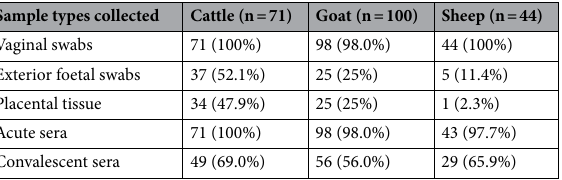
Table 1. Number and type of samples collected from abortion events for each livestock animal species, northern Tanzania, 2017–2019.